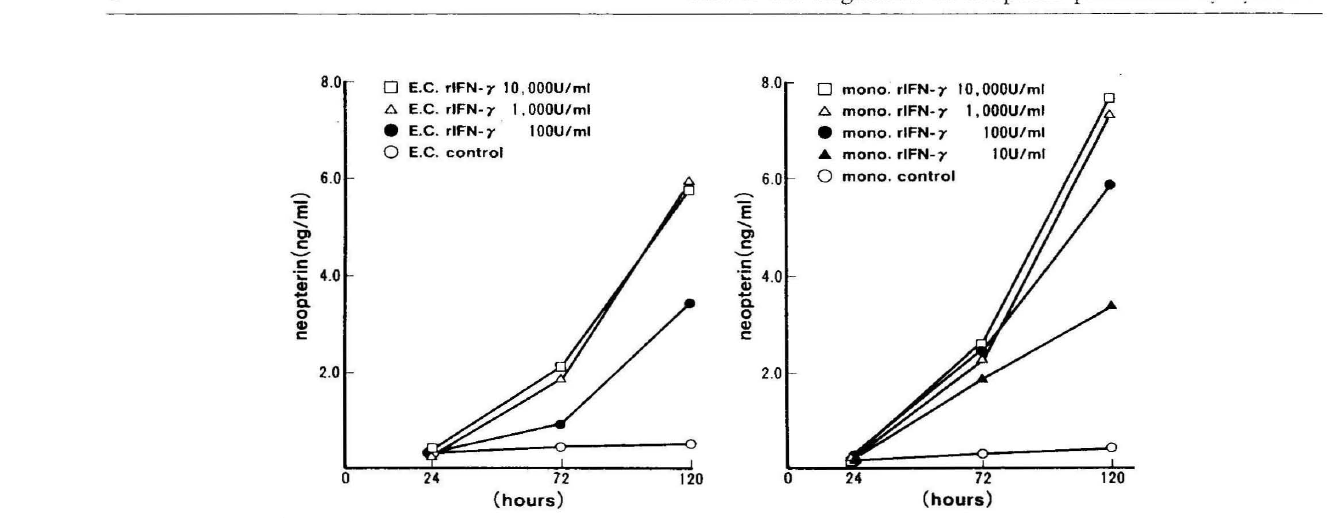
Figure 1. The effect of INF-y on neopterin production by vascular endothelial cells and monocytes in vitro. EC, vascular endothelial cells; mono, monocytes.